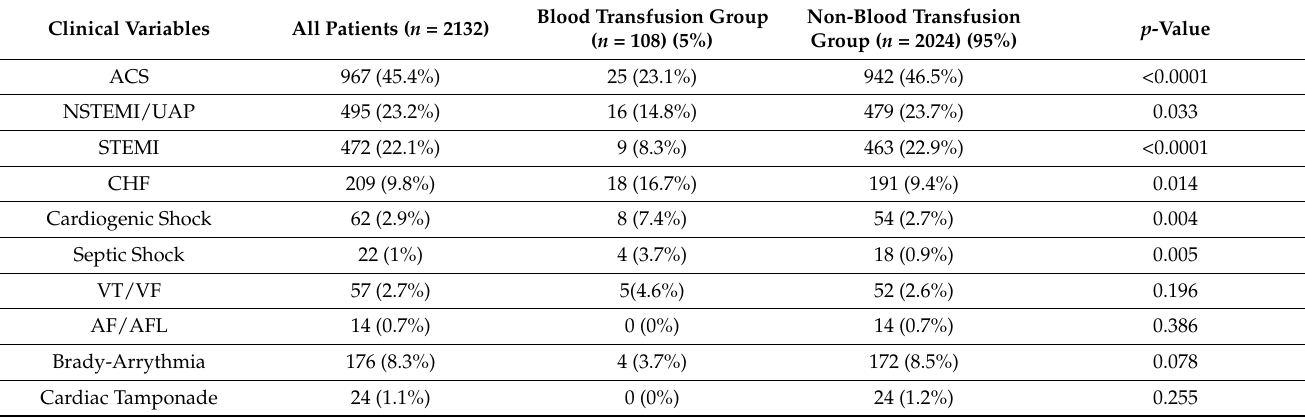
Table 2. Blood transfusion vs. non-blood transfusion according to diagnosis on admission.